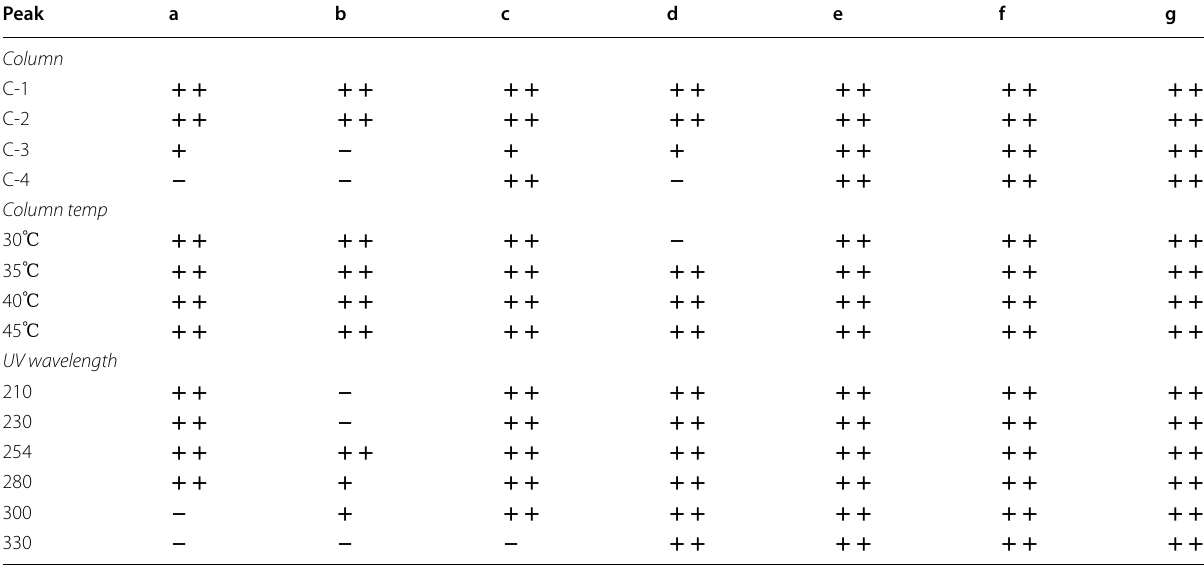
Table 1 Comparison of column, column temperature and UV wavelength for optimization of analytical method